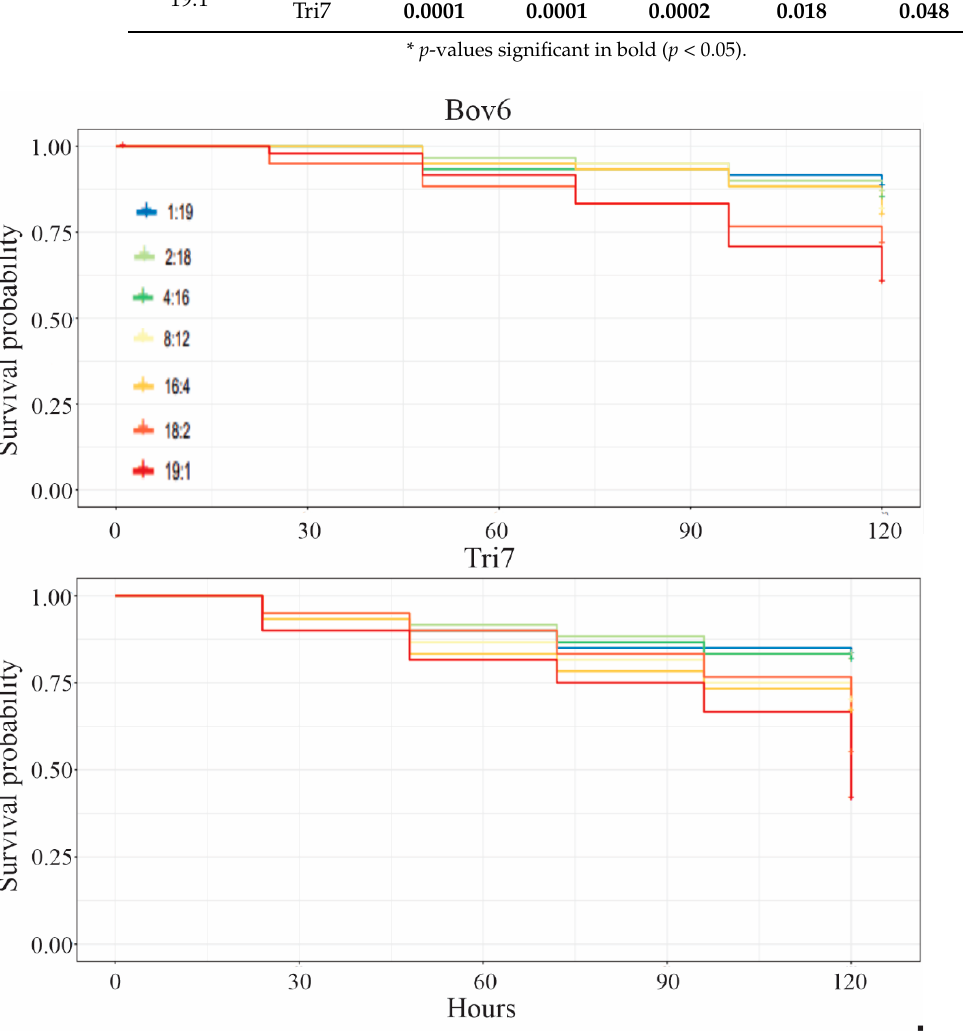
Figure 3. Survival curve of groups of Atta sexdens rubropilosa Forel 1908 (Hymenoptera: Formicidae) workers immersed in suspensions of Beauveria bassiana (Bov6) and Trichoderma harzianum (Tri7).